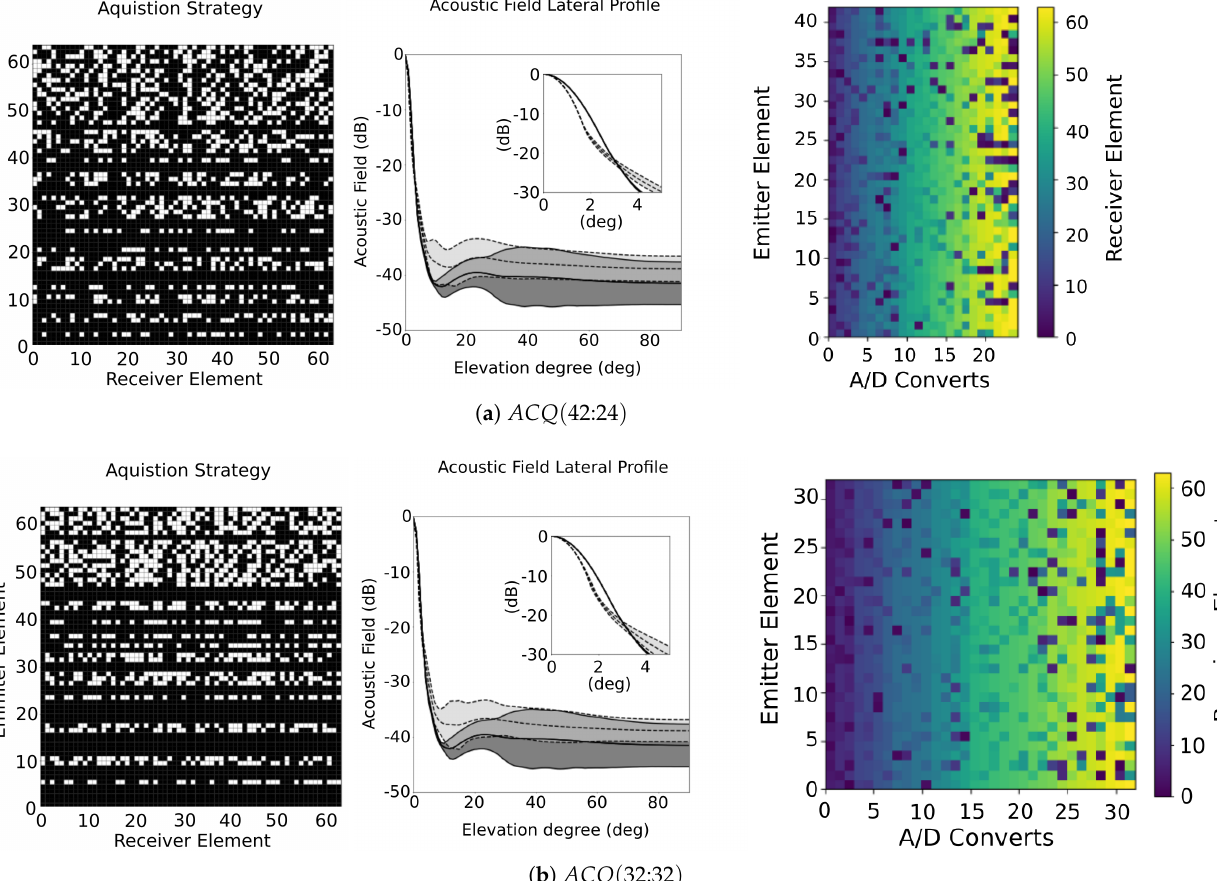
Figure 11. Results obtained from ACQ ( a ) ( 42:42 ) , and ( b ) ( 32:32 ) , where the acquisition strategy is presented in the left, the sidelobe distribution at each elevation angle for strategies is illustrated at the centre, and the configuration of the multiplexer net showing, at each shot, the distribution of reception transducer in the reception channels is illustrated in the right. For the sidelobe distribution, the current ACQ is represented in light grey area within the dashed line, and the FMC is represented as the dark grey area within the